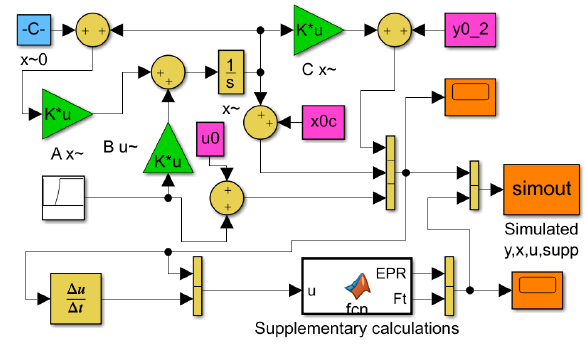
Figure 6. MATLAB® Simulink® software